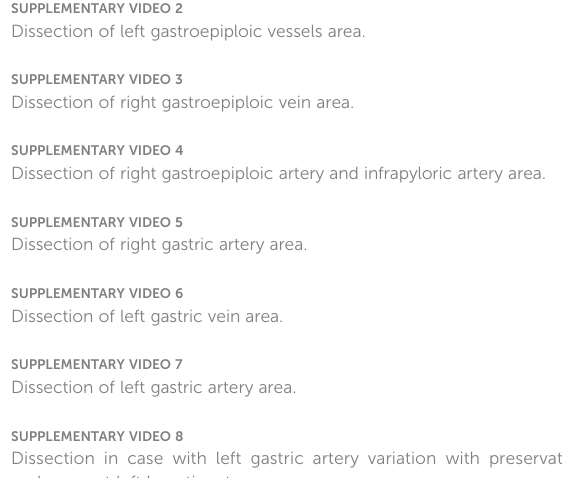
SUPPLEMENTARY VIDEO 5 Dissection of right gastric artery area. SUPPLEMENTARY VIDEO 6 Dissection of left gastric vein area. SUPPLEMENTARY VIDEO 7 Dissection of left gastric artery area. SUPPLEMENTARY VIDEO 8 Dissection in case with left gastric artery variation with preservation of replacement left hepatic